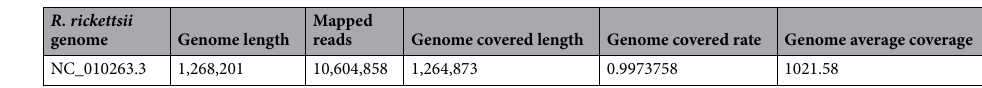
Table 2. Alignment results of R. rickettsii